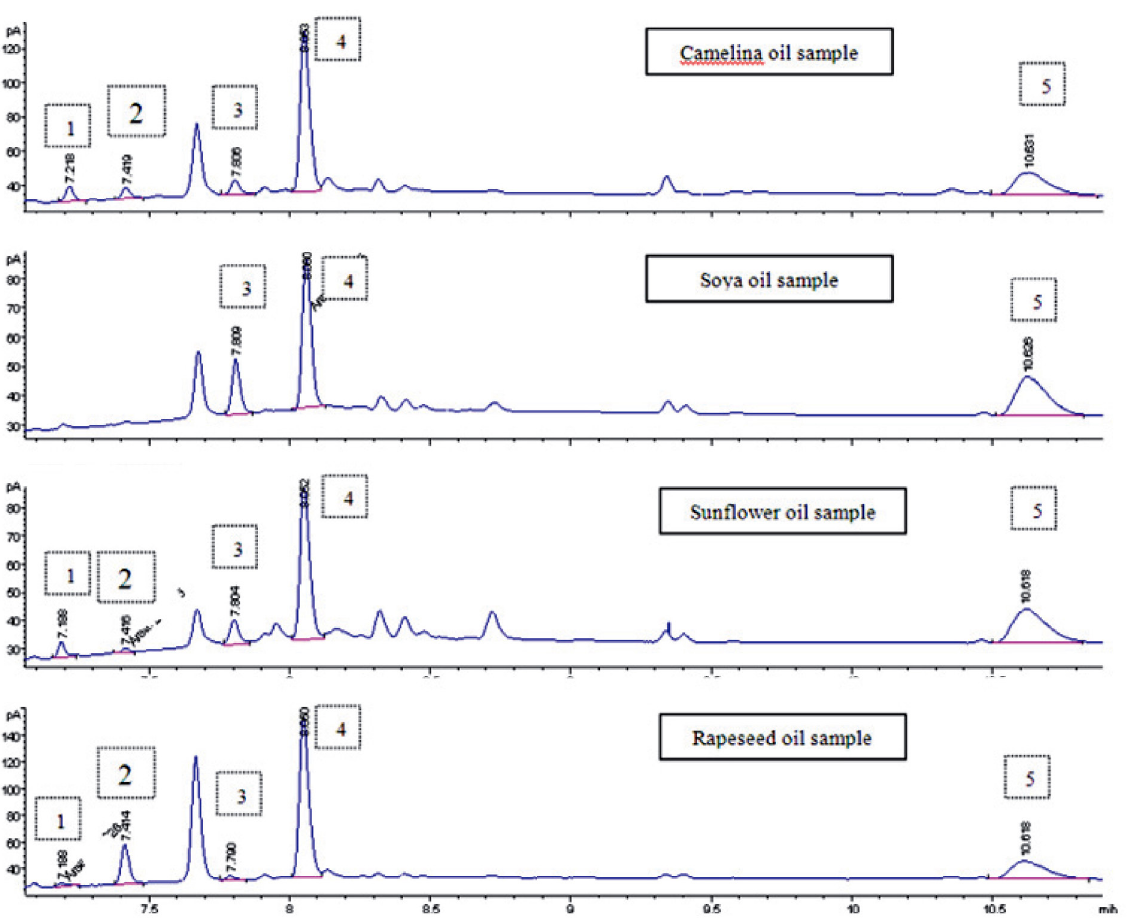
Figure 2. Comparison of camelina, soya, sunflower and rapeseed oil sample gas chromatogram: identifiers are the same as in Table 1.